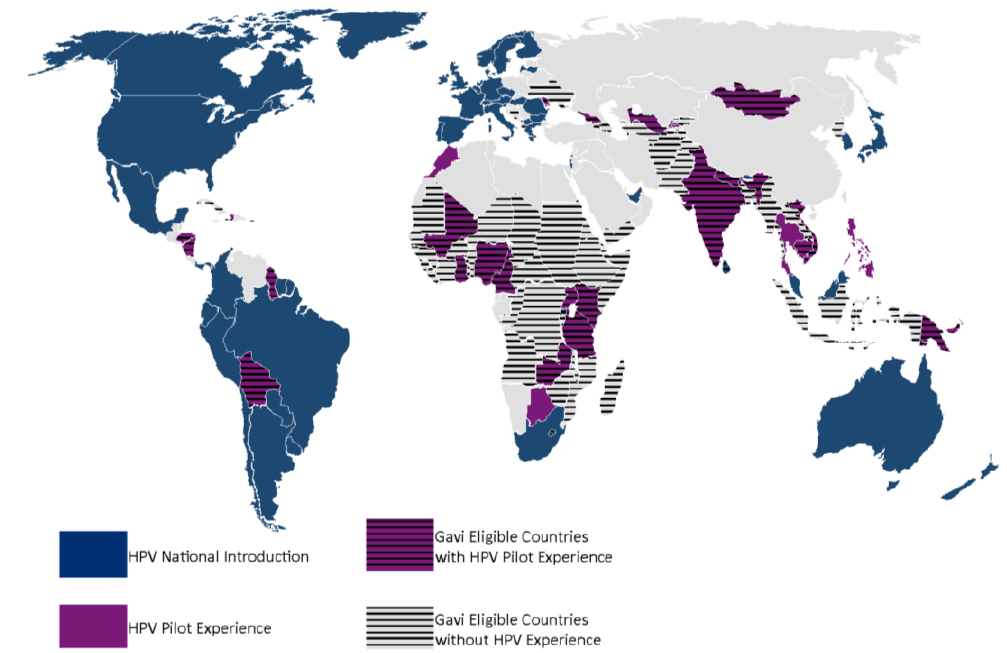
Figure 2. Global map showing HPV vaccination experience in Gavi eligible and non-eligible countries. As of 1 January 2015, only three Gavi eligible countries have introduced HPV nationally, Bhutan, Lesotho and Rwanda. The majority of Gavi eligible countries have not had experience with HPV vaccination. Few Gavi eligible countries have had pilots previous to the development of the Gavi HPV demo program and without Gavi